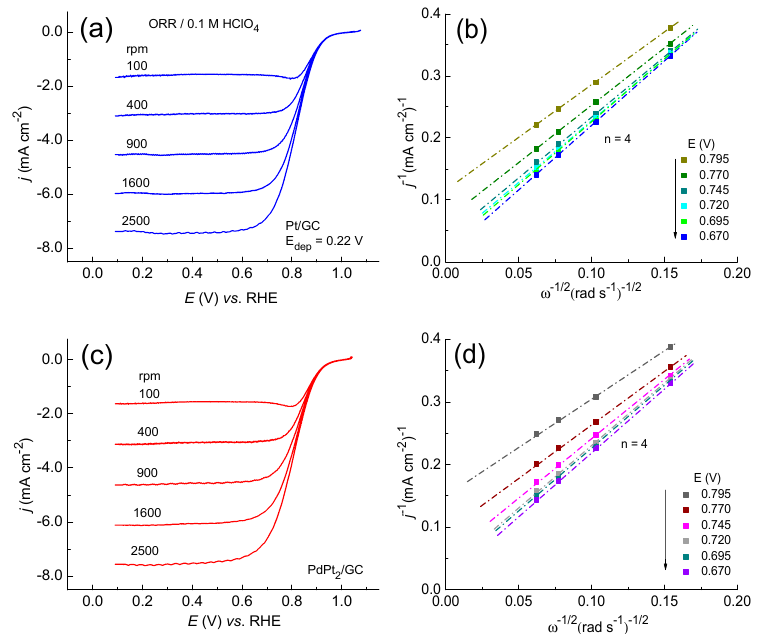
Figure 7. Polarization curves for ORR in 0.1 M HClO 4 on ( a ) Pt/GC; ( b ) Corresponding K–L plot; ( c ) PdPt 2 /GC; and ( d ) Corresponding K–L plot. Scan rate 50 mV s − 1 . The total number of exchanged electrons calculated from Equation (5) using the experimental values from K–L plots is four for both the PdPt 2 /GC and Pt/GC electrodes. The ORR activity also proceeds through a four-electron reaction pathway on various Pt single crystals [57] and polycrystalline Pt [9,58]. Figure 8 shows the polarization curves for the ORR on the PdPt 2 /GC and Pt/GC electrodes recorded in oxygen-saturated 0.1 M HClO 4 with the same rotation rate of 1600 rpm and corresponding Tafel slopes. For comparison, the polarization curve for Pt(poly) is also shown.